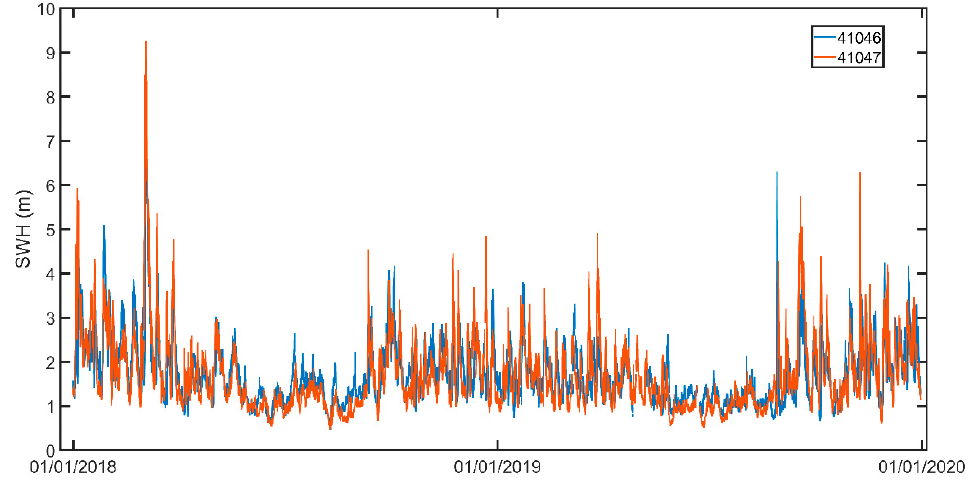
Figure 2. Time series of significant wave height (m) recorded by National Data Buoy Center (NDBC) buoys 41046 (blue) and 41047 (red) over the 2-year, 2018–2019, period.